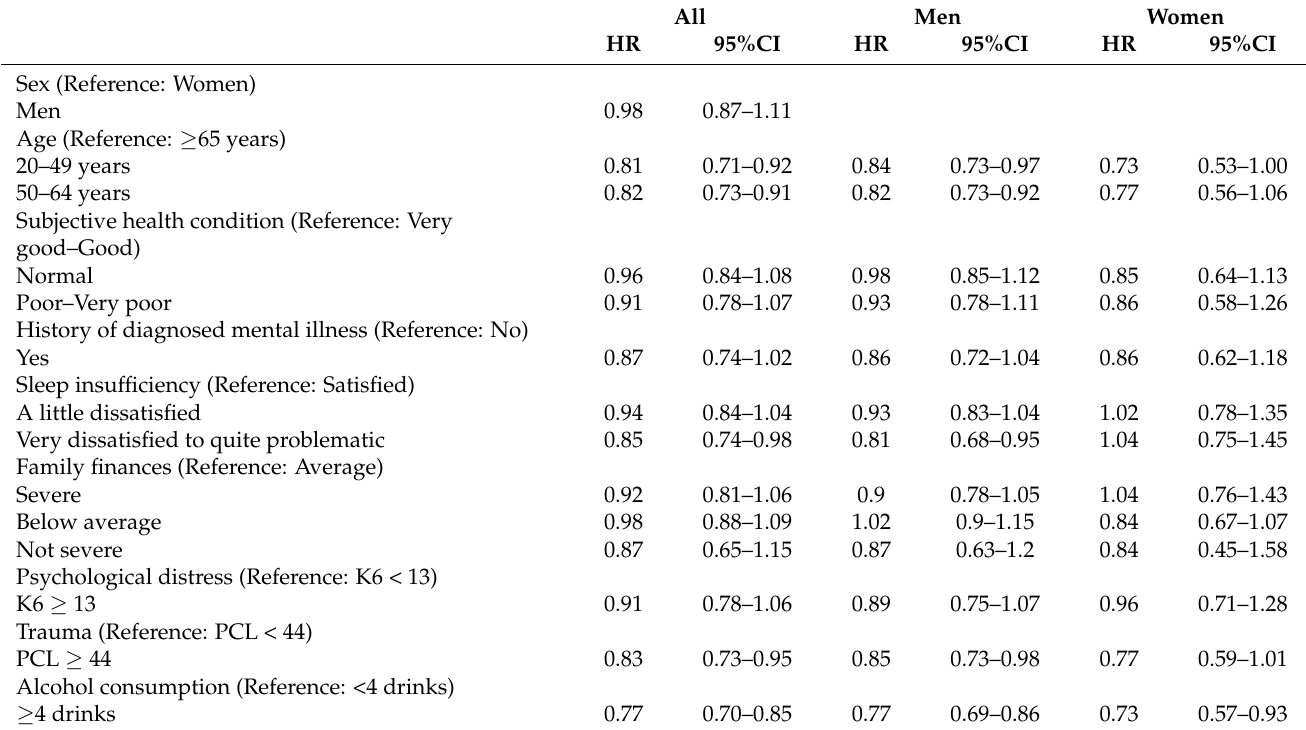
Table 6. Multivariate-adjusted HRs and 95% CIs for recovery from problem drinking from FY 2012 to FY